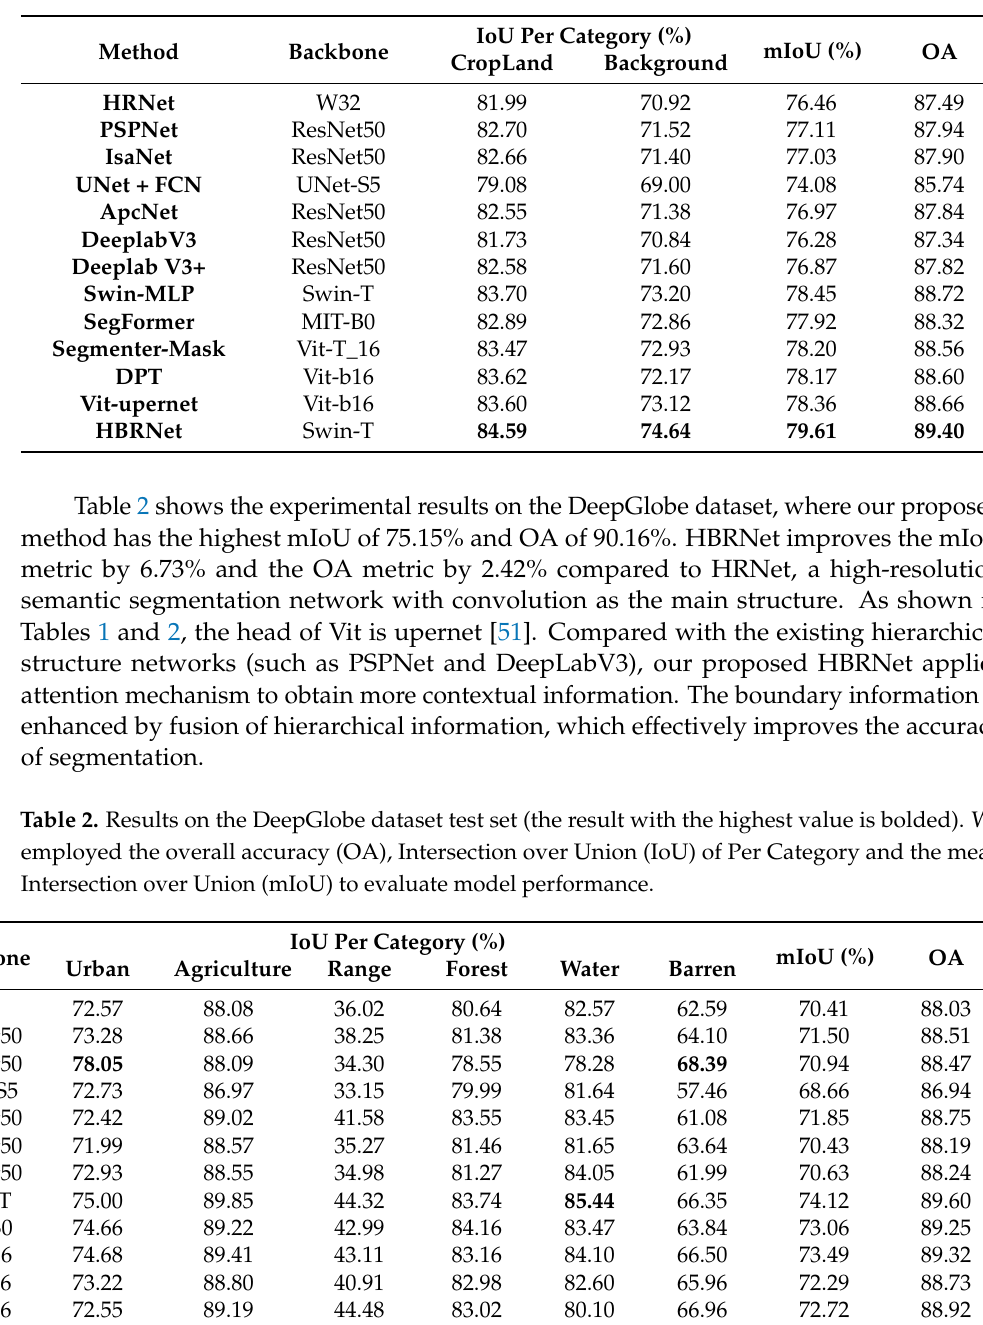
Table 1. Results on the Agriculture dataset test set (the result with the highest value is bolded). We employed the overall accuracy (OA), Intersection over Union (IoU) of Per Category and the mean Intersection over Union (mIoU) to evaluate model performance.